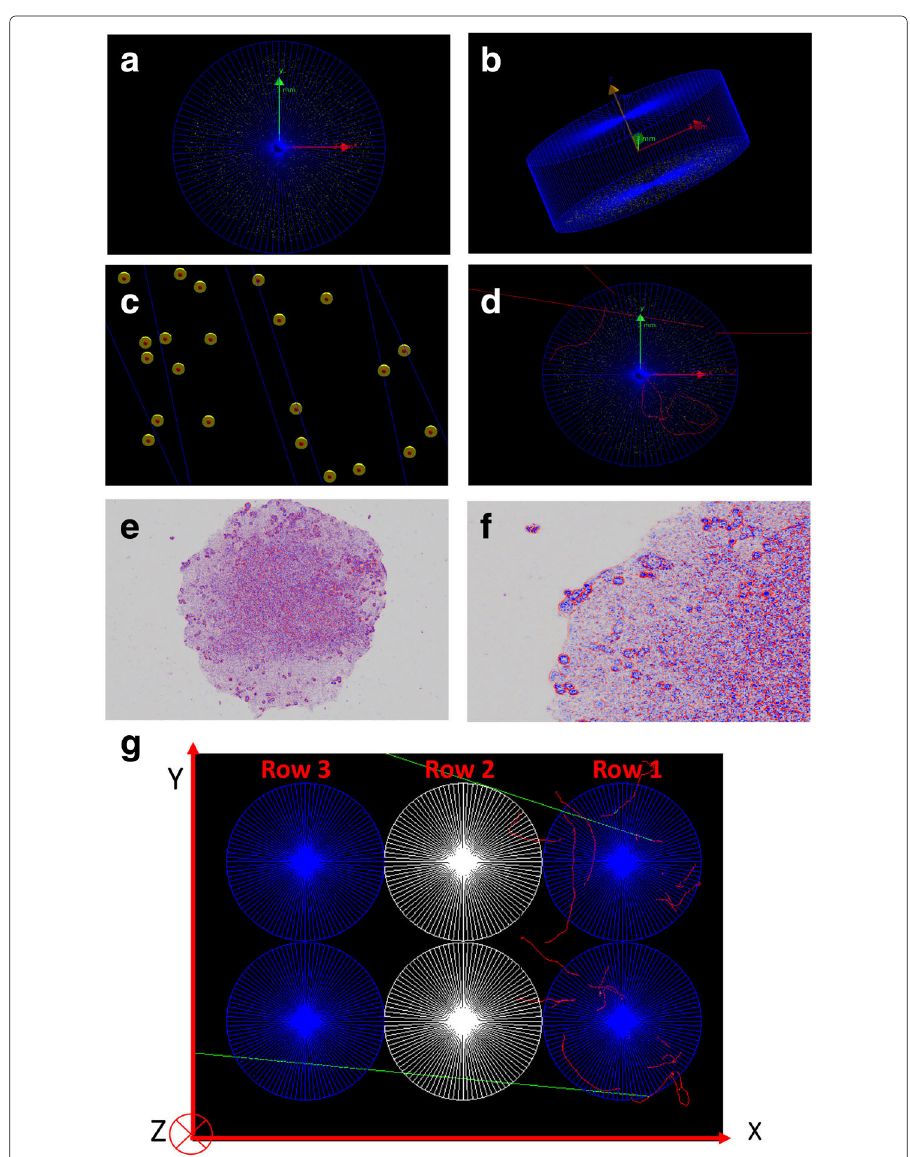
Fig. 3 Geometry set-up in the GATE simulations: a , b 5000 non-overlapping spherical cells randomly distributed in a cylindrical well (axial and cross-sectional views); c yellow and red spheres representing the cytoplasm and nucleus respectively; d beta particle tracks (red) in the well; e microspcopy image of a cell culture configuration in a single well; f zoom-in of image in ( e ); g six adjacent wells in three rows: row 1: active rows with each well containing 288 kBq 90 YCl 3 in 200 μ l cell culture medium, row 2: wells with 200 μ l of water, and row 3: with two well only containing 200 μ l cell culture medium. The red and green tracks represent emitted beta particles and scattered photons (from the atomic de-excitations), respectively